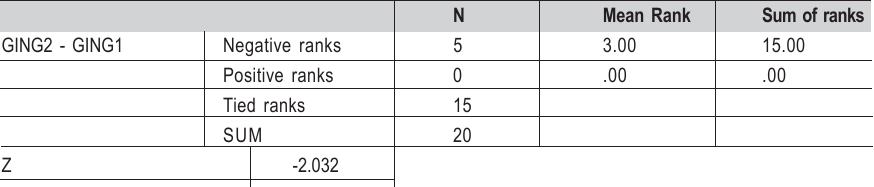
Table 3. Statistical analysis of gingival tissue status before and after use of CHX mouthwash.